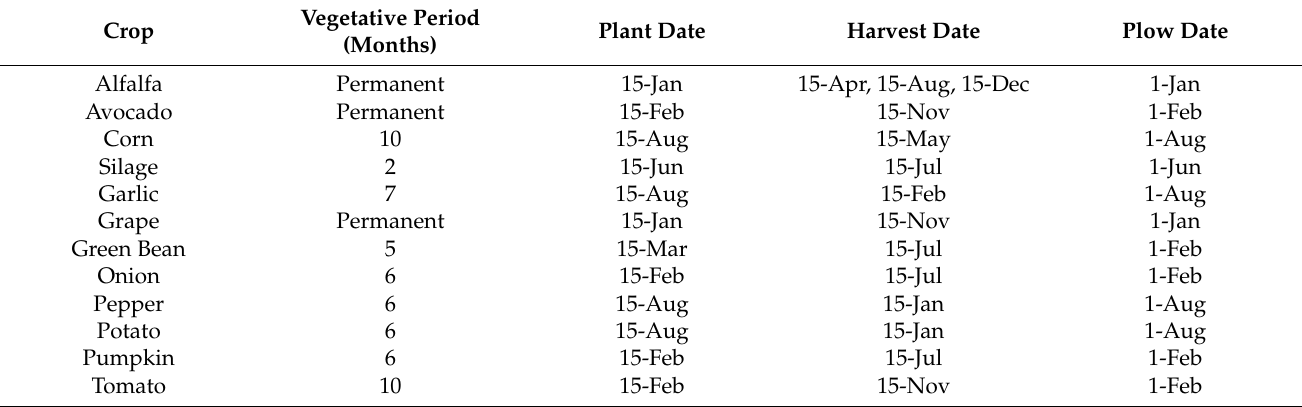
Table 2. Agricultural crop types in the Majes region.